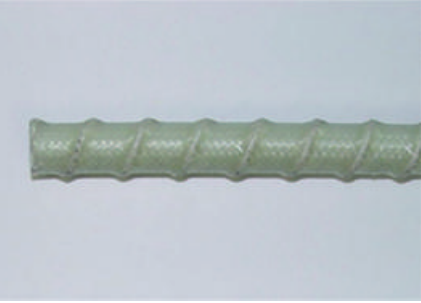
Figure 2: GFRP rebar of KICT [17].